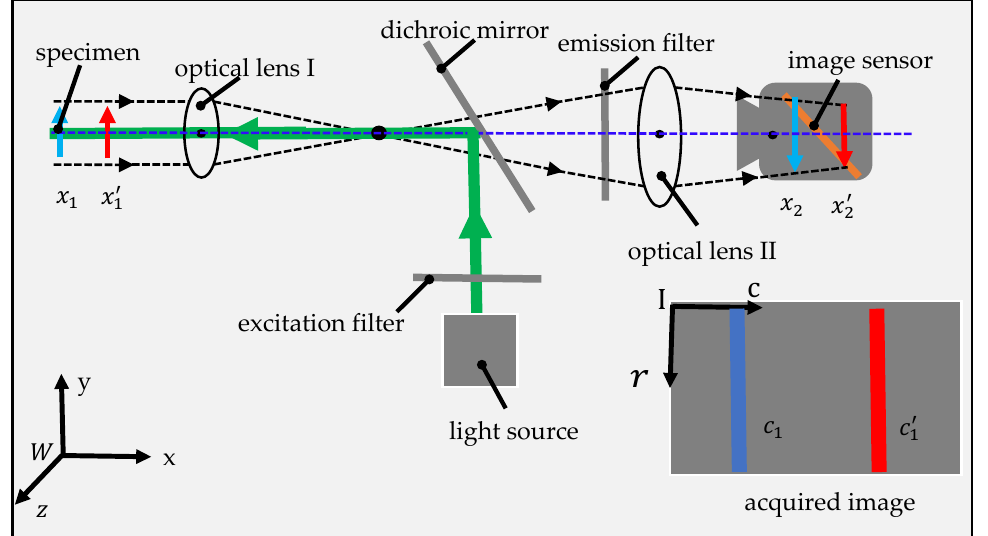
Figure 2. Optical diagram of high-speed image-based system for measuring the motion of living tissues. The system illustrated above has a simple structure, which makes it easy to integrate into the front end of a minimally invasive instrument to measure the motion of living tissues in vivo.